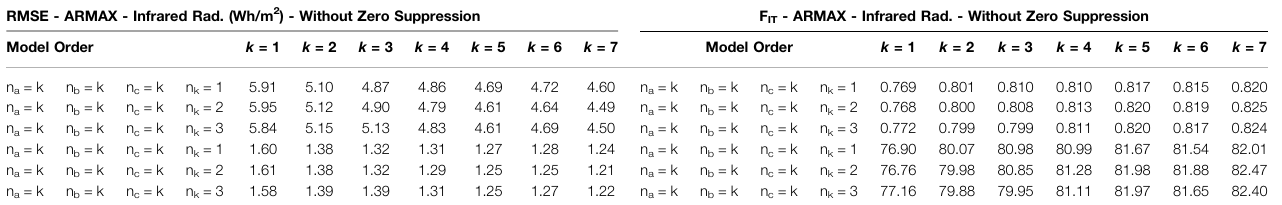
TABLE 4 | RMSE and F IT values for horizontal infrared horizontal radiation model ARMAX. RMSE - ARMAX - Infrared Rad. (Wh/m 2 ) - Without Zero Suppression F IT - ARMAX - Infrared Rad. - Without Zero Suppression Model